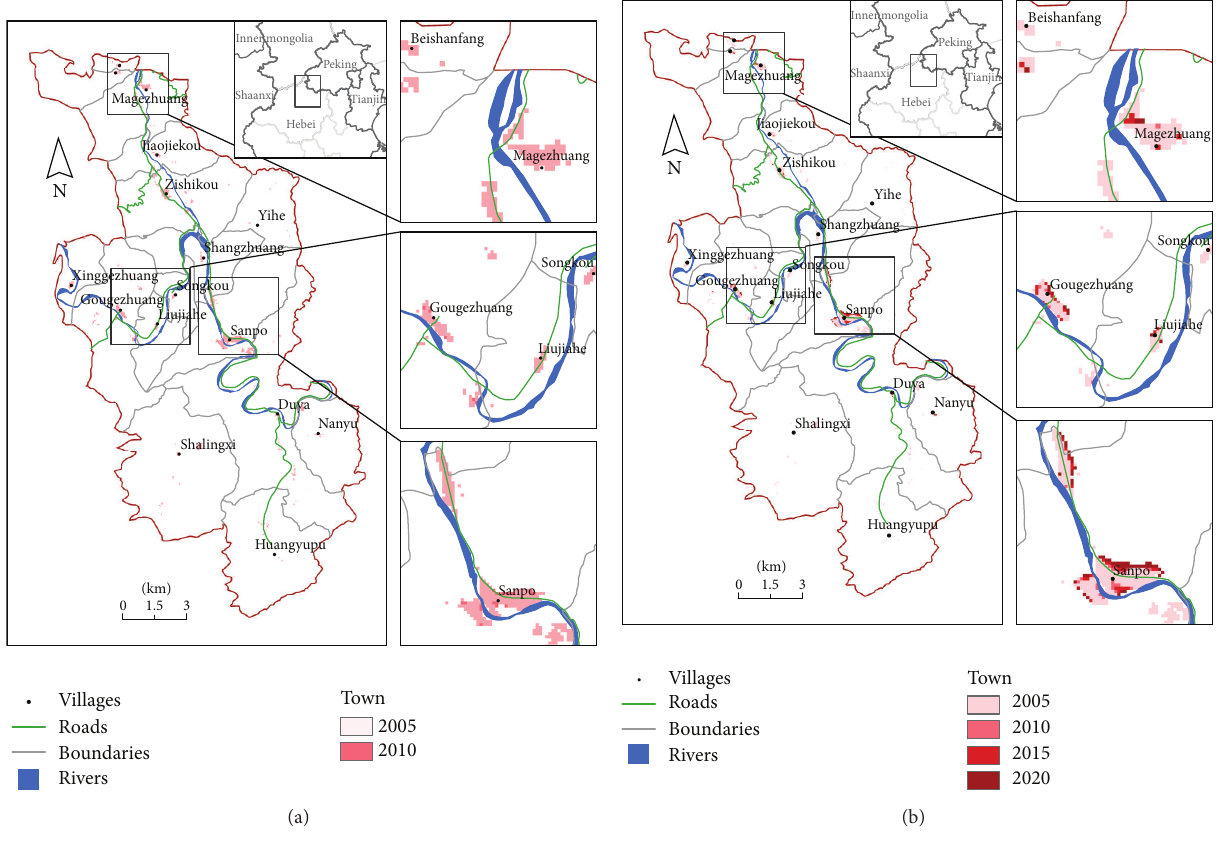
Figure 4: Spatio-temporal growth simulation results of